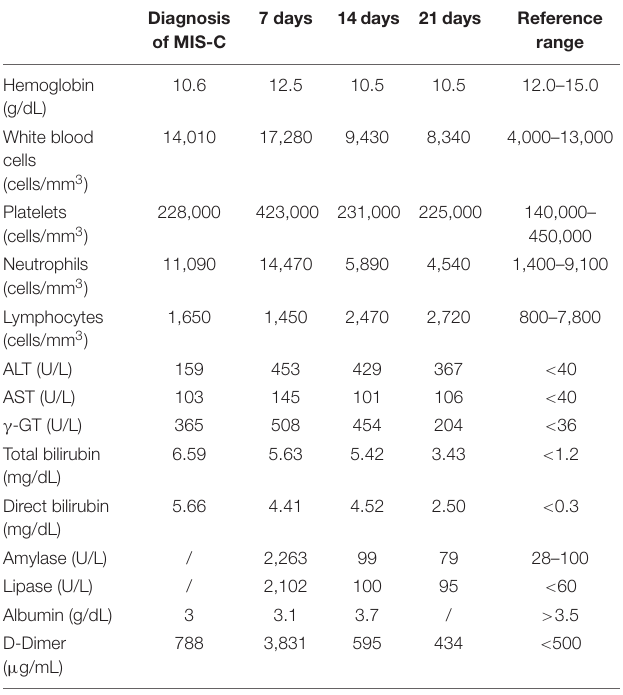
TABLE 1 | Laboratory assessment at disease presentation and during